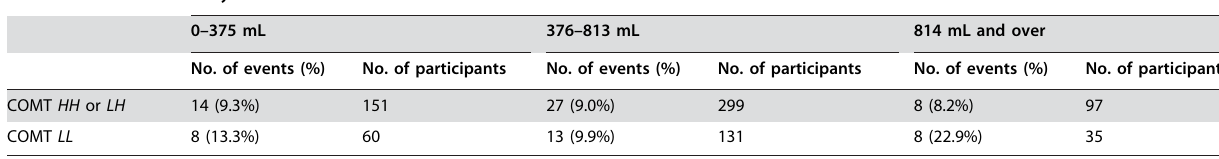
Table 3. Distribution of acute coronary events in the study population during an average follow-up of 13 years, according to the